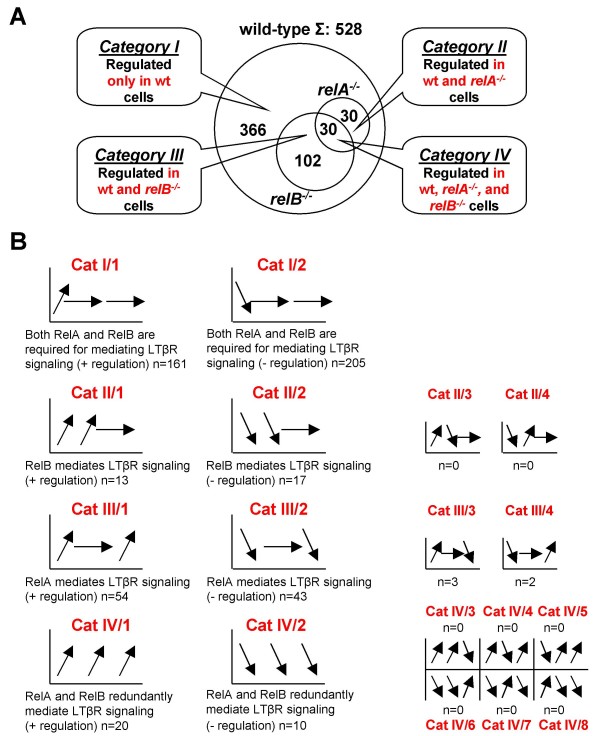
LTβR-responsive genes can be allocated into distinct categories. (A) Venn-diagram of significantly (p < 0.05) regulated genes. (B) Schematic depiction of gene expression patterns. The four main categories in (A) can be segregated into further subcategories, depending on whether their genes were upregulated or downregulated. The arrows in the plots show the direction of gene expression changes from non-induced (0 h) to the 10 h induced state in response to LTβR stimulation. The first arrow describes gene expression behavior in wild-type, the second in relA-/-, and the third in relB-/- cells. Horizontal arrows indicate lack of change or statistically insignificant change in gene expression. Arrows pointing upwards or downwards indicate significant positive or negative regulation, respectively.